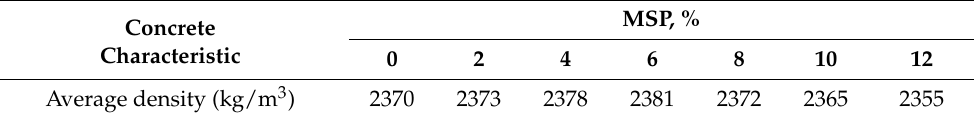
Table 5. Results of determining the actual density of concretes of all experimental compositions.